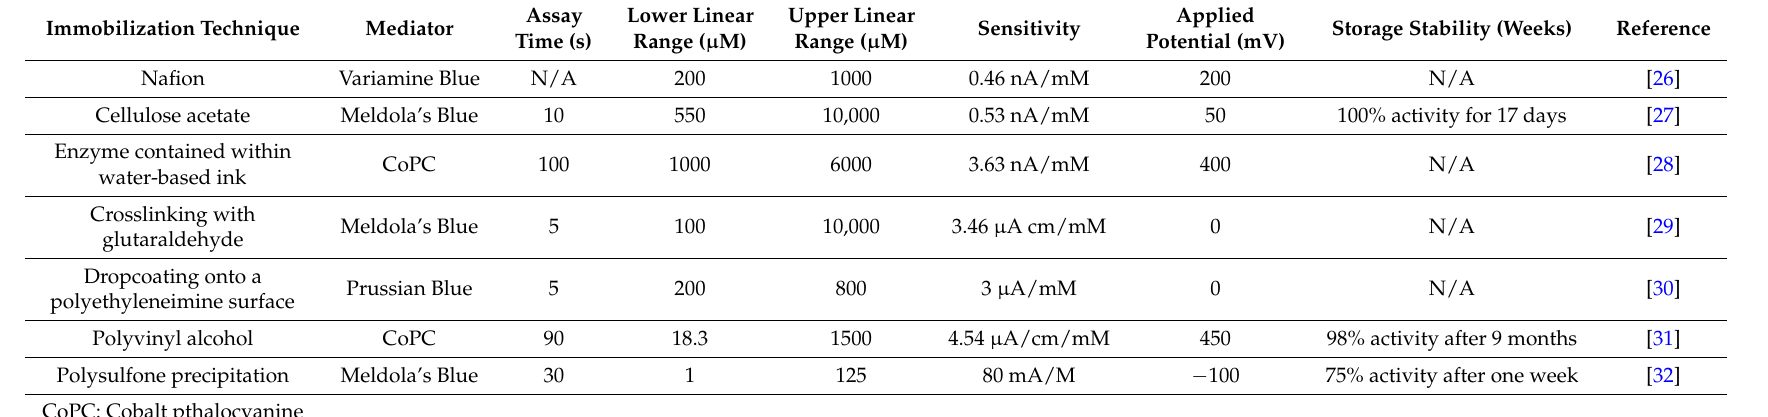
Table 4. Reports of screen-printed carbon electrodes for lactate